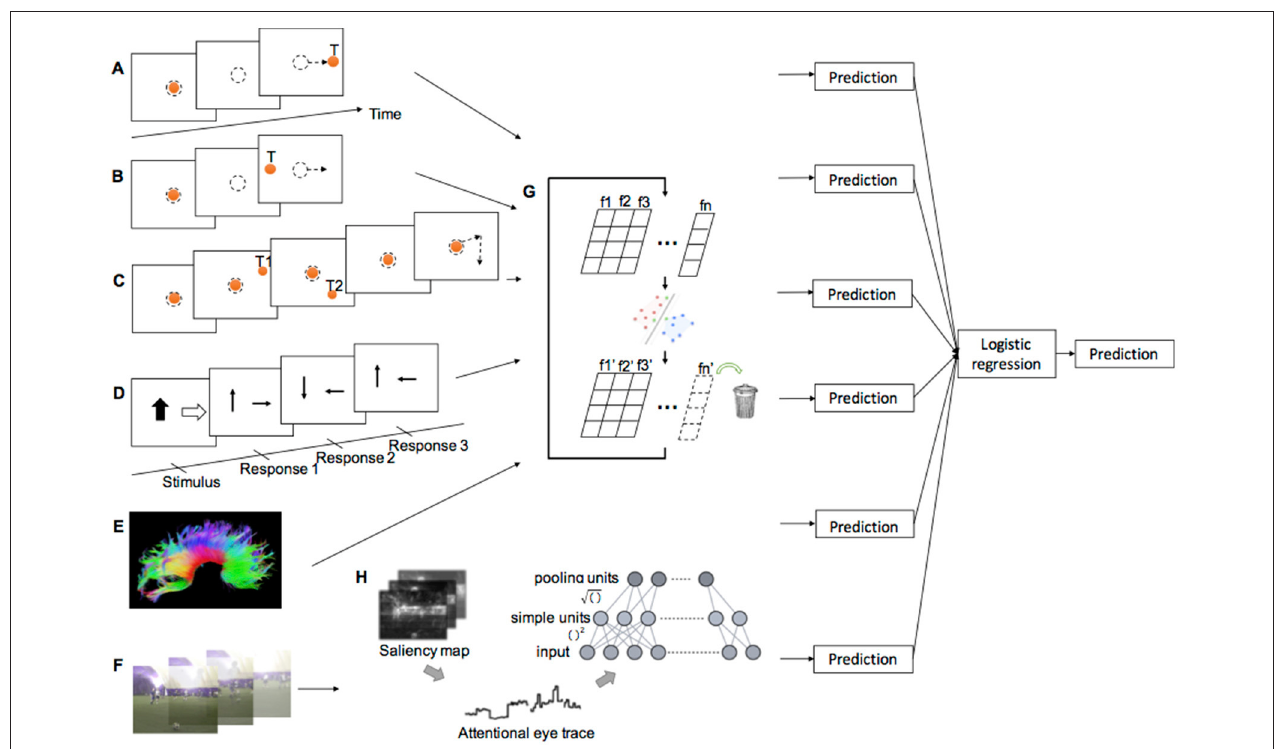
FIGURE 1 | Illustration of experimental methods and classification procedure. (A) Prosaccade task. (B) Antisaccade task. (C) Memory-guided saccade task. (D) Inhibition subtests of psychometric tests (see Supplementary Material for test description) (E) DTI. (F) Natural viewing task. (G) SVM-RFE. (H) Attentional eye traces and Tiled